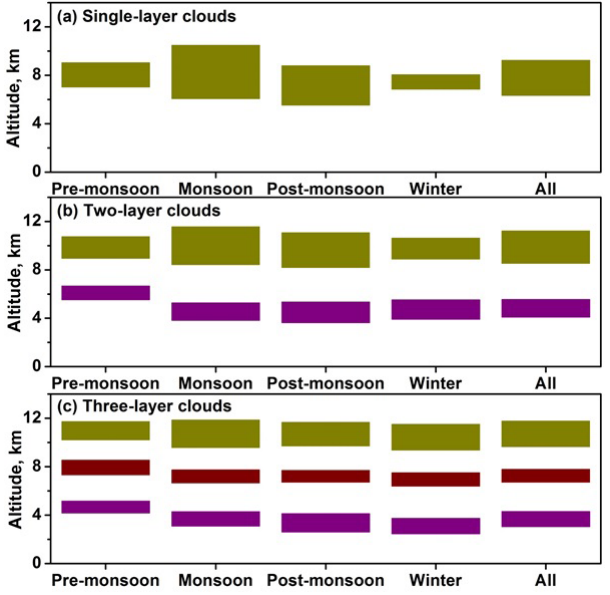
Figure 11. Mean vertical locations (base and top) and cloud thick- nesses of (a) one-layer clouds, (b) two-layer clouds, and (c) three- layer clouds observed during different